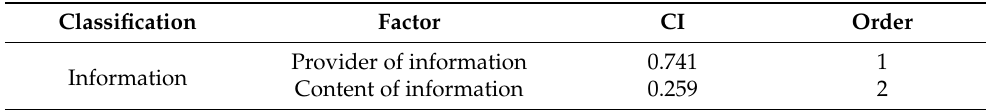
Table 6. Results of the relative importance of the information in H3. Classification Factor CI Order Provider of information 0.741 1 Information Content of information 0.259